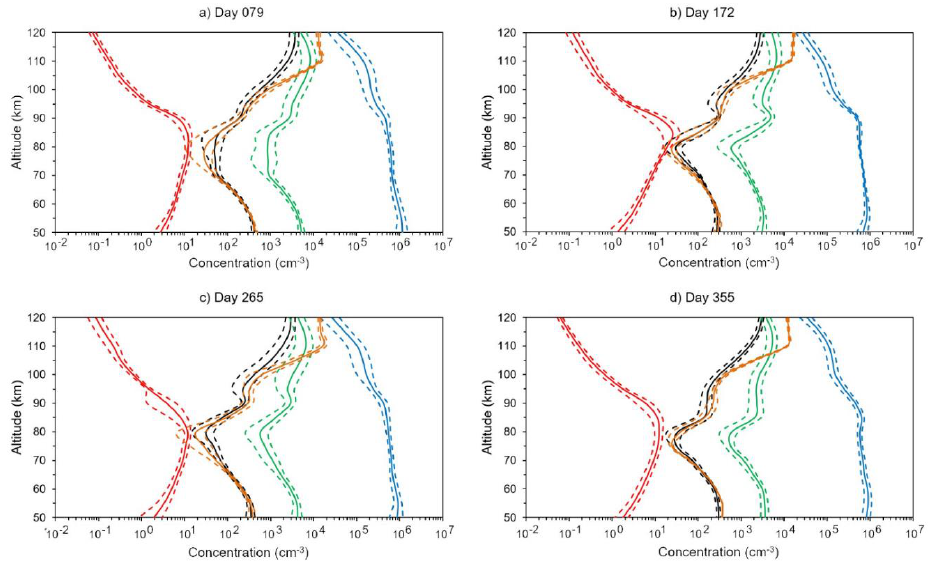
Figure 13. Daily mean altitude profiles of O 2 (b 1 Σ g + , v = 0) (blue solid line), O 2 (b 1 Σ g + , v = 1) (green solid line), O 2 (b 1 Σ g+ , v = 2) (red solid line), O( 1 D) (black solid line) and their standard deviations (dashed lines) calculated via YM2011 based on TIMED-SABER data for 4 days in 2010: ( a ) day 79, ( b ) day 172, ( c ) day 265, ( d ) day 355. Orange lines represent altitude profiles of O( 1 D) according to TIMED-SABER data.